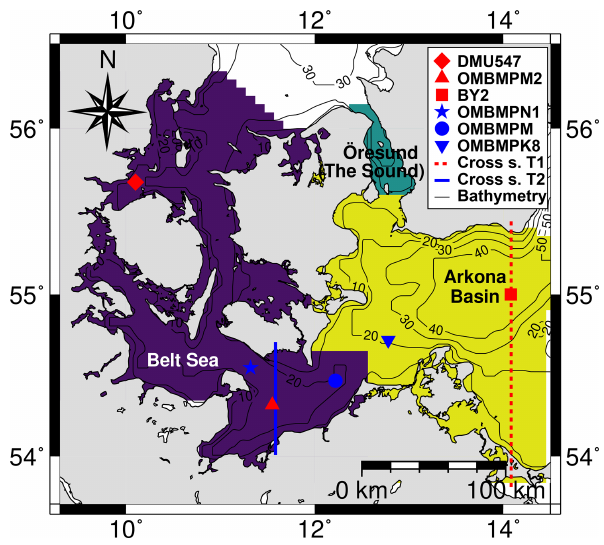
Figure 4. Basins in the western Baltic Sea according to Omstedt et al. (2000) drawn in yellow (Belt Sea), green (Arkona Basin), and cyan (Öresund). Measurement stations are indicated by red and blue symbols. Cross sections for model evaluation are indicated by red dashed and blue solid lines. Red stations and lines are considered in this paper (top three stations in the legend) and blue stations and lines in the Supplement (items four to six in the legend). The dark thin lines with numbers attached are isolines of the bathymetry. The numbers give the depth in